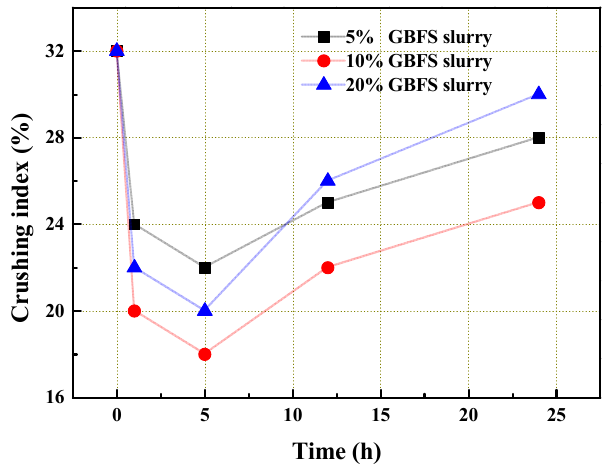
Figure 5. The crushing index of the coral aggregate that was treated with the GBFS slurry.